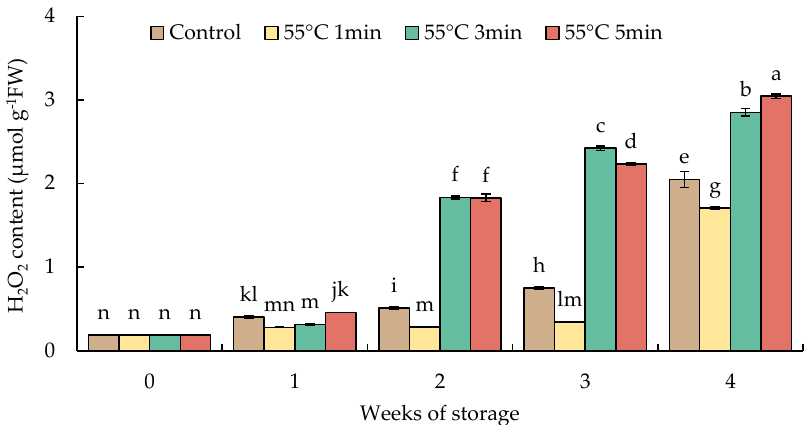
Figure 7. Effect of hot water treatment (55 ◦ C for 1, 3, 5 min) on hydrogen peroxide content in red sweet pepper fruit during storage at 10 ◦ C. Data represent means ± S.E. (n = 3). Different letters on bars are significantly different ( p < 0.05).